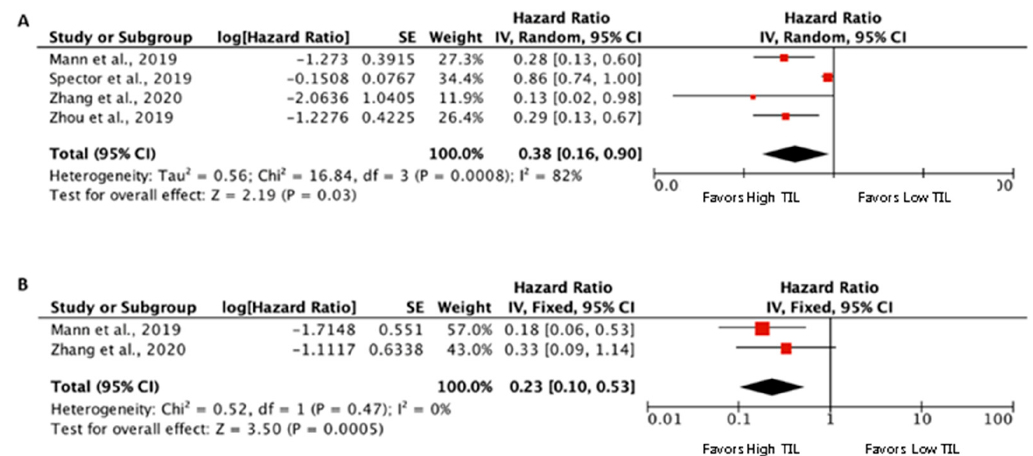
Figure 4. Forest plots of prognostic value of stromal and/or tumoral CD3+/CD4+ TIL on overall survival ( A ) and disease-free survival ( B ).